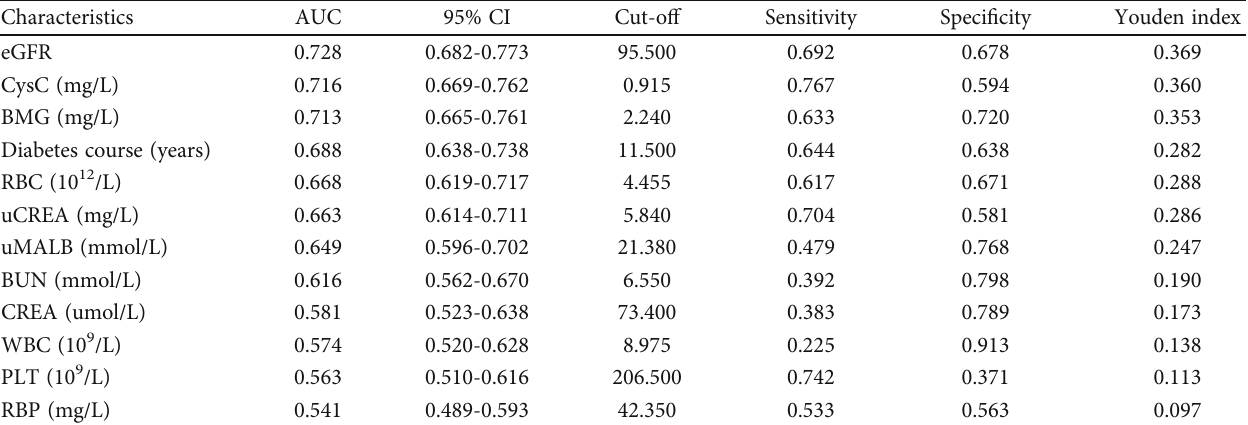
Table 3: AUCs, cut-o ff , sensitivity, and speci fi city of risk factors in ROC analysis to predict PAD.